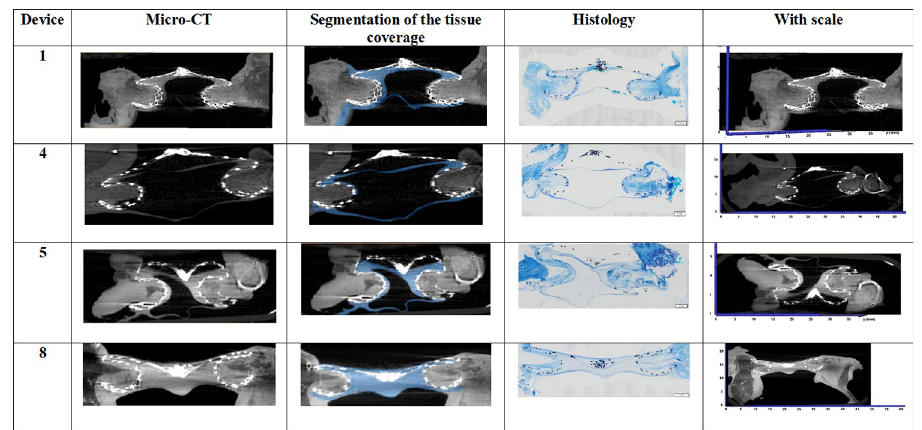
Fig 7. Central Illustration presenting examples of segmentation of the tissue coverage to improve comparison of micro-CT and histology sections. Device 1 explanted after one-month follow-up; Devices 4–8 explanted after 3-month follow-up. The first column shows a slice from raw 3D reconstruction of 4 devices presenting the occluder with covering tissue surrounded by myocardium. The secund column is a segmentation of the tissue that was formed in and around the disks of the devices. The third column shows the corresponding histology section of each device. The fourth column shows the slice from the first column with a